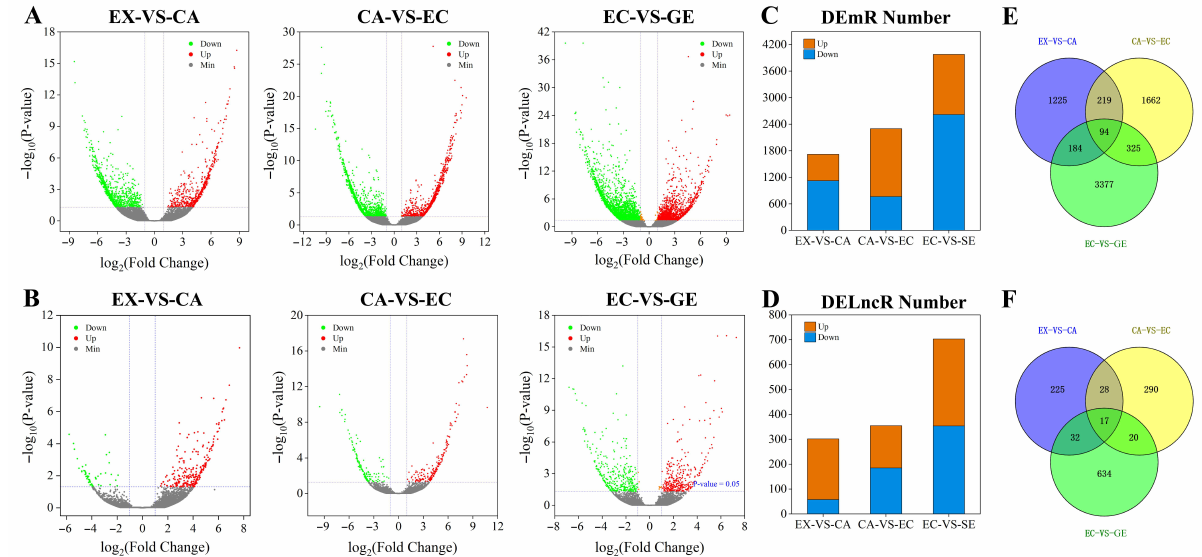
Figure 3. Differential expression analysis of lncRNAs and mRNAs during somatic embryogenesis of garlic. The differential expression volcano maps of mRNAs and lncRNAs at different stages ( A , B ); the number of differentially expressed mRNAs and lncRNAs at different stages of somatic embryo development ( C , D ). Orange was up-regulated and blue was down-regulated. Venn diagrams of differential expression of mRNAs and lncRNAs at different stages ( E , F